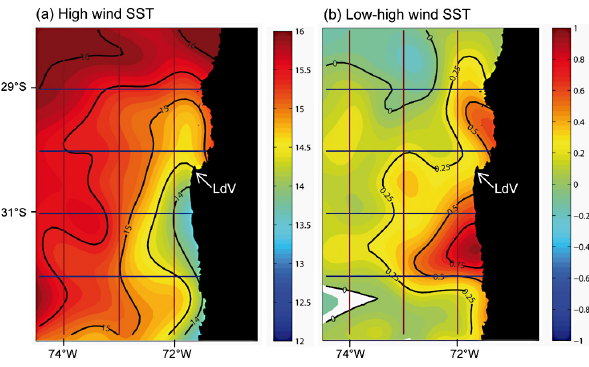
Fig. 7. Sea surface temperature (SST) derived from the Special Sensor Microwave/Imager (SSM/I; see details in Wentz 1997). (a) Average of SST during the high-wind period (24 November to 2 De- cember 2009). Contours every 0.5 ◦ C. (b) SST difference between low-wind days (22 November, 23 November, 3 December, 4 De- cember) minus high-wind period. Contours every 0.25 ◦ C Arrow- head indicates location of point Lengua de Vaca.